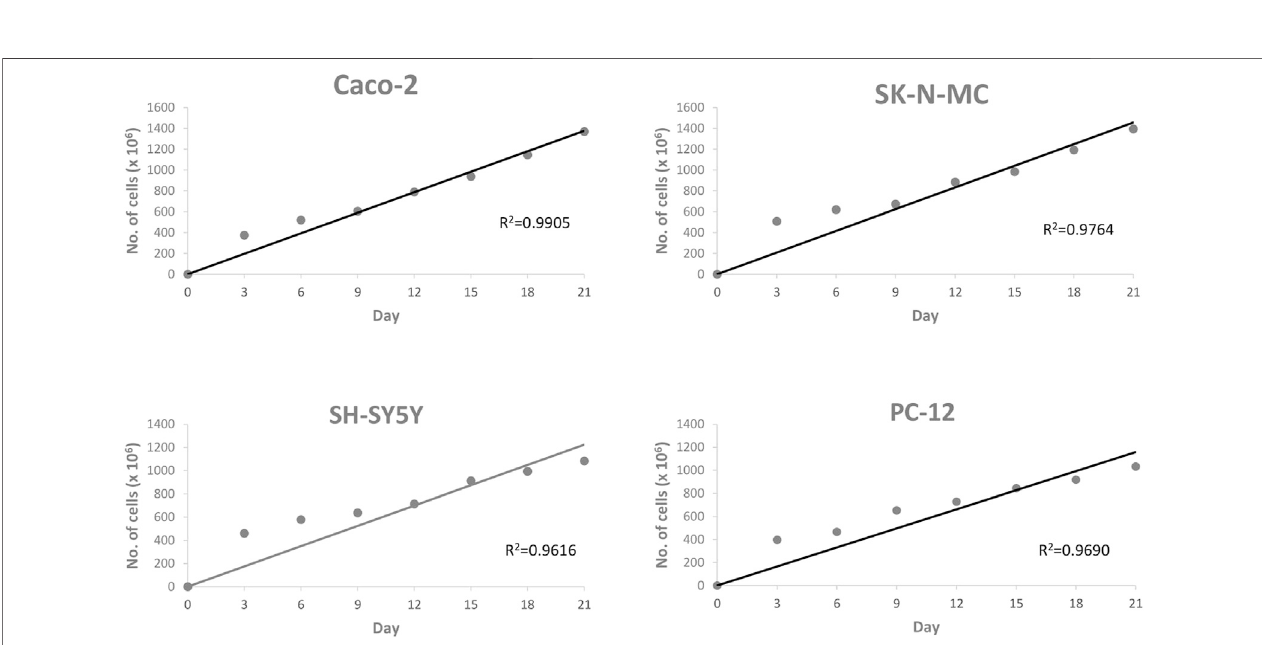
FIGURE 2 | Scattered plot shows the correlation between cell lines and day of culture. Values are given as 1 × 10 6 (mean ± SEM) for three independent biological determinations.